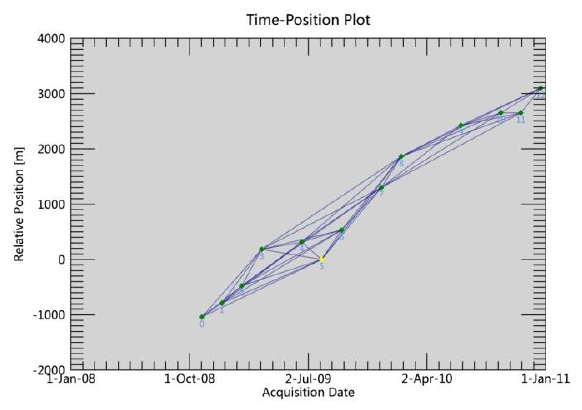
Figure 2. Time and space baselines of the interferogram of ALOS